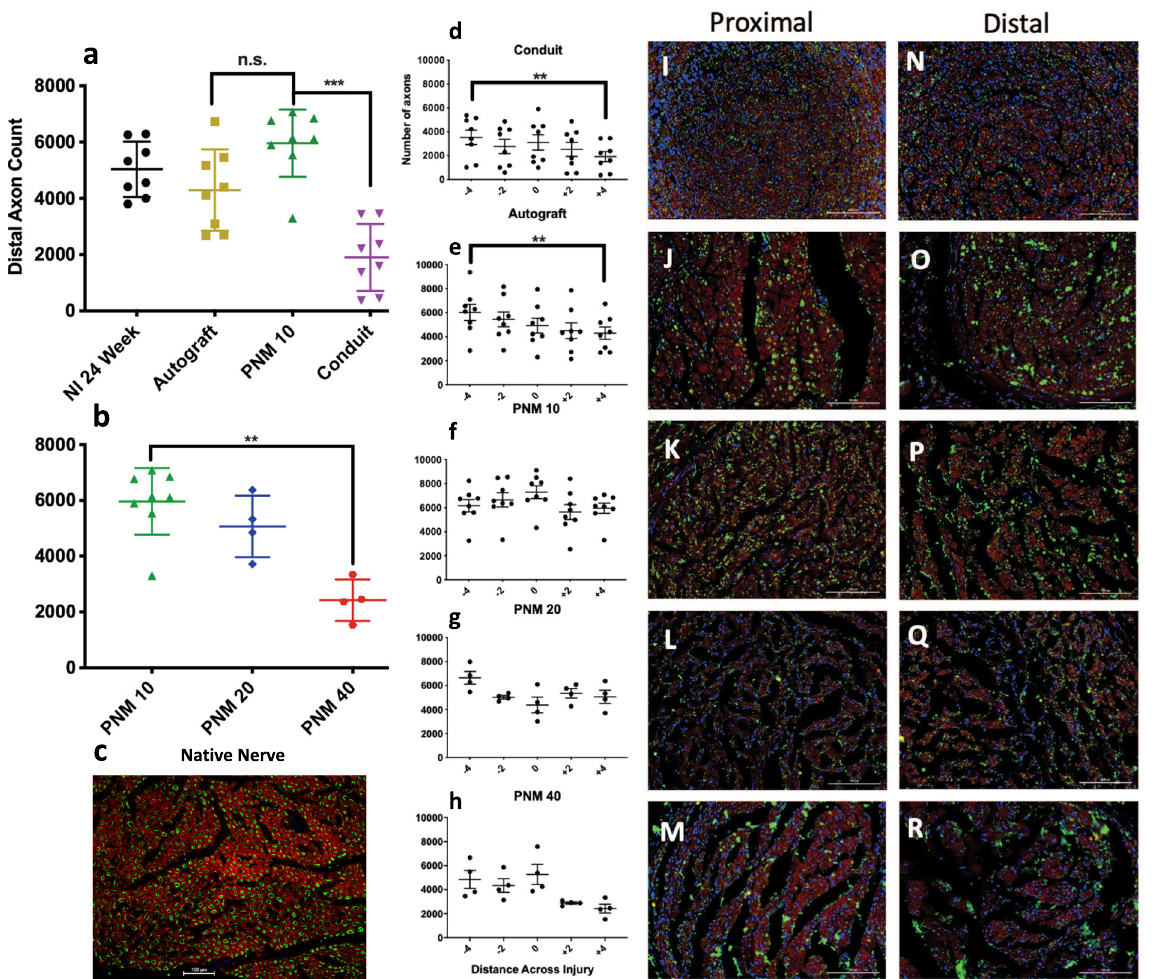
Fig. 6 Axon quanti fi cation and qualitative morphological appearance. a Axon counts for each group. b Comparisons of axon counts between concentrations of PNM. C Representative cross-section of a native, non-injured rat sciatic nerve at ×20 magni fi cation. Scale bar 100 µm, neuro fi lament heavy chain for axons tagged in green, fl uoromyelin for myelin in red, and DAPI for nuclei in blue. d – h Longitudinal distributions of axon count for each group. i – m Representative sections at the proximal ( − 4 mm) and n – r distal ( + 4 mm) locations of the gap defect. The scale bar represents 100 μ m and images were taken at ×20 magni fi cation. Axons appear in green, myelin in red, and nuclei in blue. Data are presented as mean ± SD. P values <0.05 are denoted by *, p < 0.01 by **, p < 0.001 by ***, and p < 0.0001 by